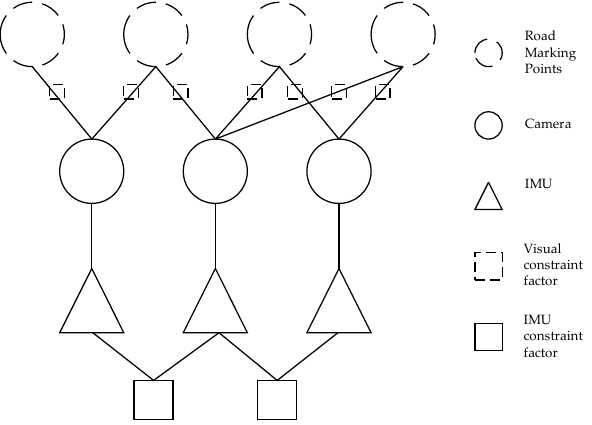
Figure 7. Factor diagram for visual-inertial positioning